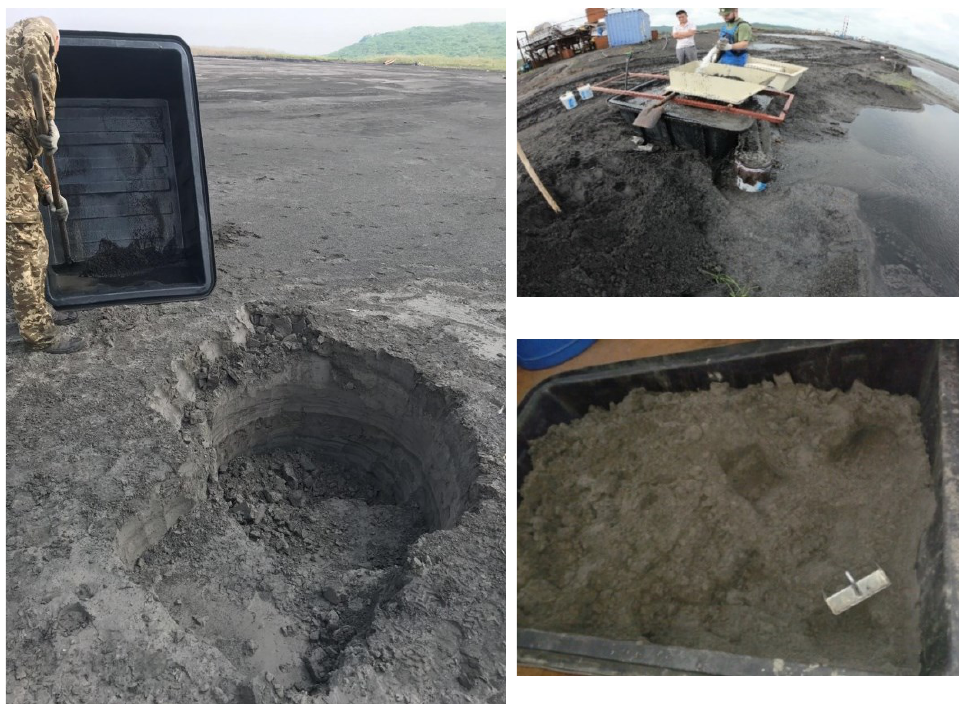
Figure 2. Selection of coal ash for research.